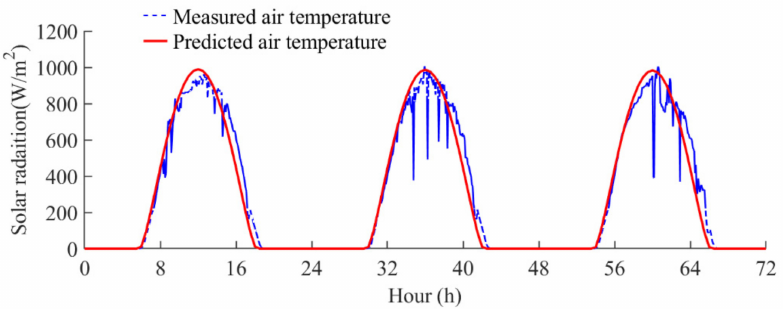
Figure 12. Comparison of the predicted and measured solar radiation.